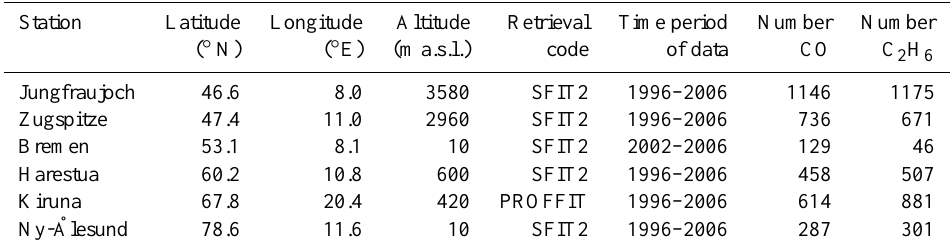
Table 2. Ground-based solar FTIR stations participating in the EMEP model comparison with available time period and number of measure- ments for each